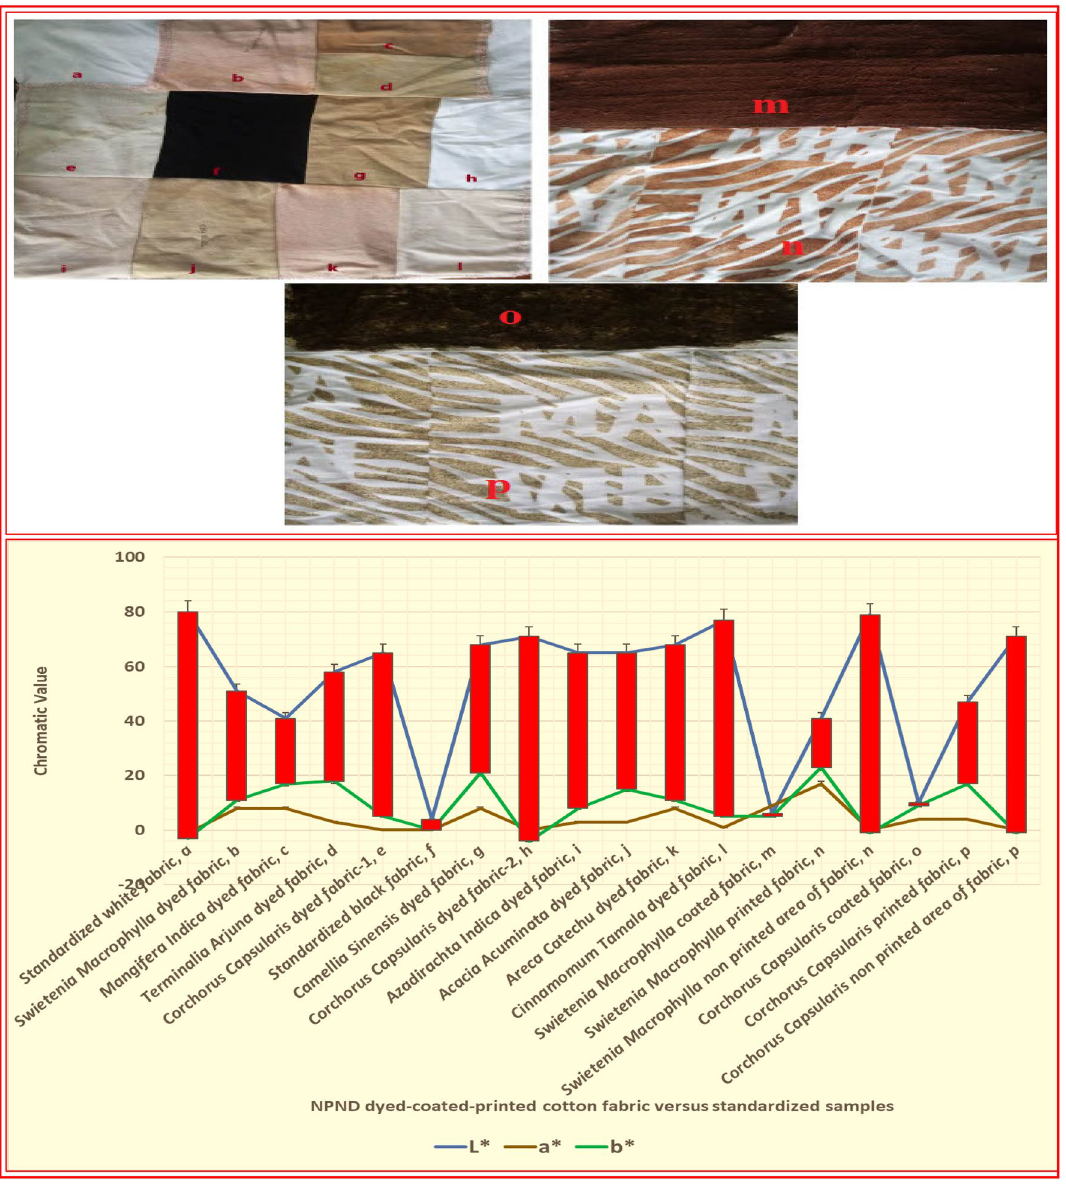
Figure 2. NPND dyed cotton fabric with solid color design compared with standardized white and black fabric ( a – l ), NPND coated cotton fabric with solid color design ( m , o ) and NPND printed cotton fabric with leafy design ( n , p ) including chromatic value of CIE L*, a*,